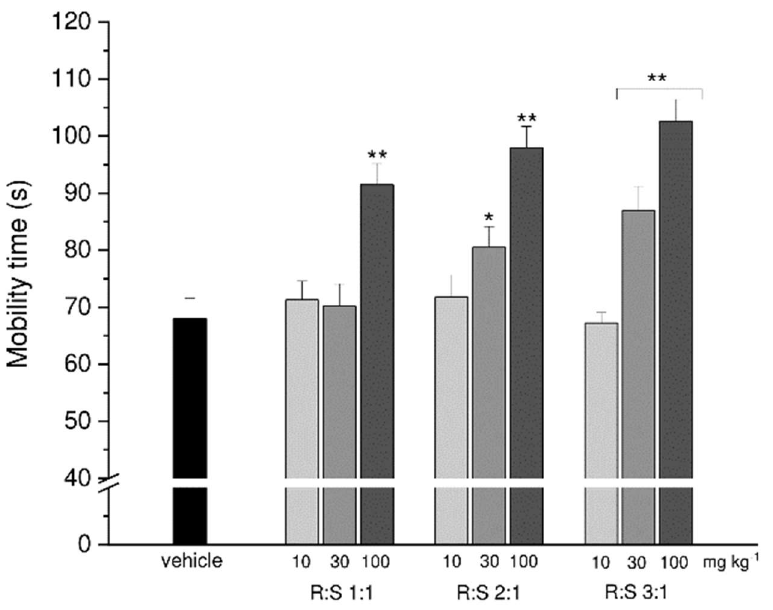
Figure 6. Effect of R:S 1:1, R:S 2:1 and R:S 3:1 on depressive-like behavior in mice in the forced swimming test. Mobility time (s) was recorded during the last 4 min of the test. Compounds R:S 1:1,